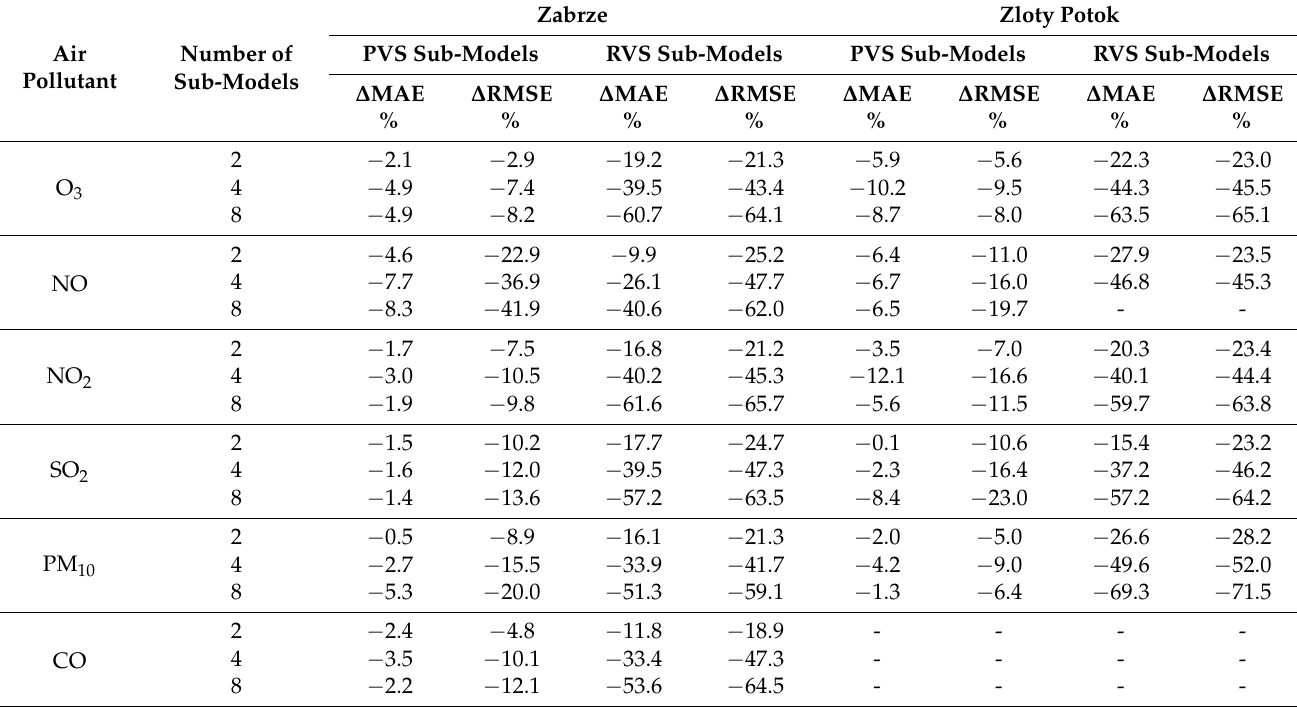
Table 25. The percentage changes in the overall values of MAE and RMSE obtained by modeling the concentrations in sub-ranges, in relation to the MAE and RMSE values of the corresponding full-range